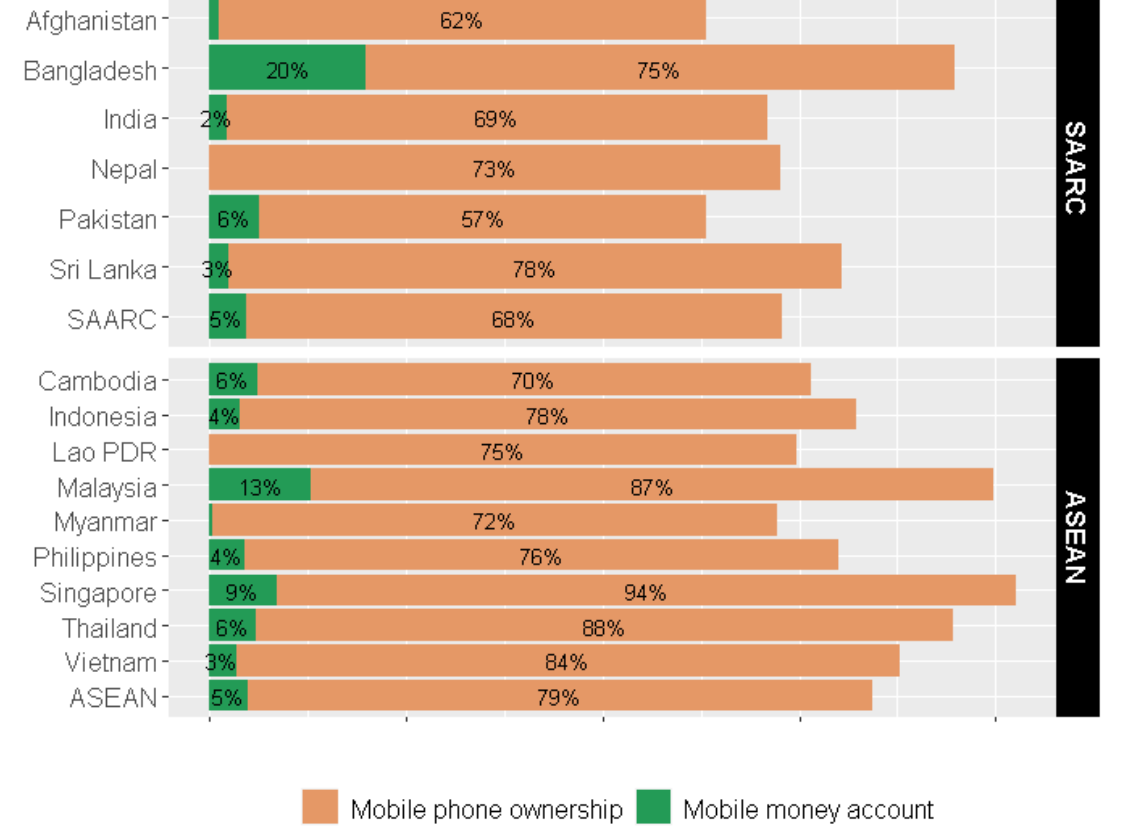
Figure 16. Percentage of participants who own a mobile phone, and who possess a mobile money account.